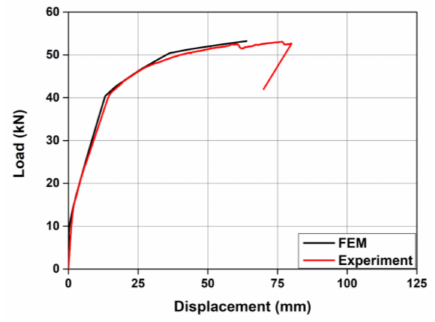
Figure 10. Comparison of load- displacement curves for